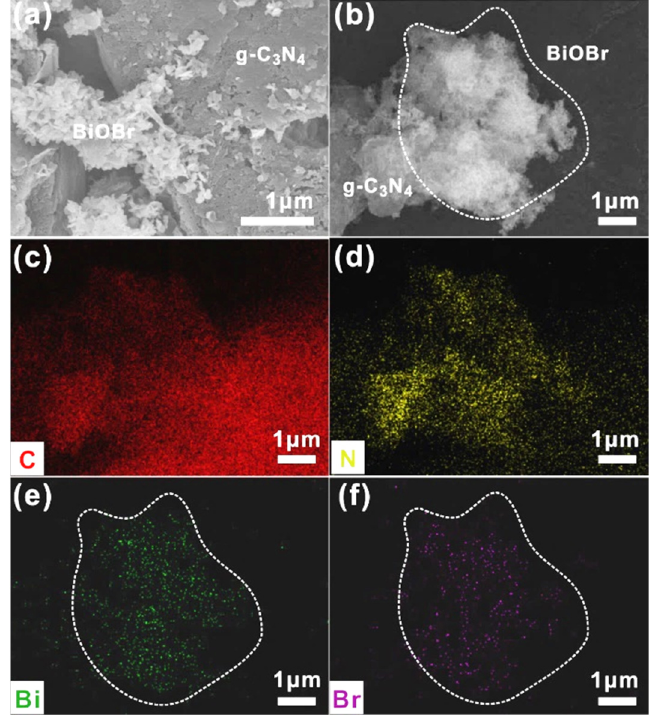
Figure 2. ( a , b ) SEM images and ( c – f ) element mapping of Bg-C 3 N 4 . The aggregated BiOBr nanoflow- ers are marked with white circle.